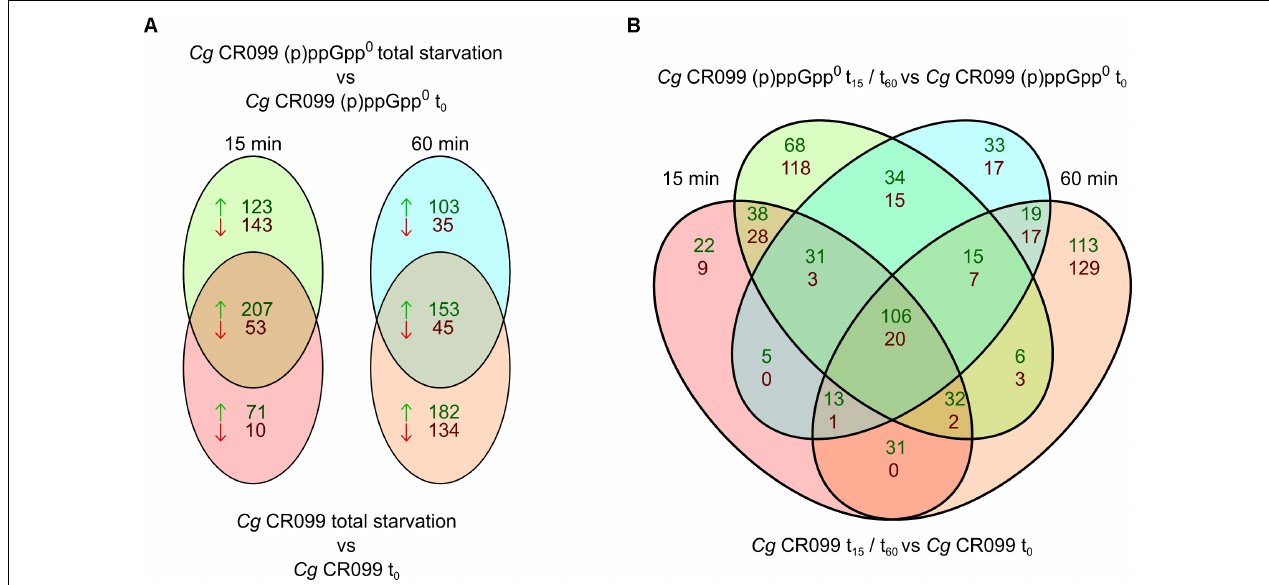
FIGURE 7 | Venn diagrams of differentially regulated genes between parental strain CR099 and (p)ppGpp 0 mutant CR099 (cid:49) rel (cid:49) relS (cid:49) relH for two stress exposure durations. For both strains, the stress-induced change in transcript levels was determined in relation to the unstressed initial state. (A) Venn diagrams of individual stress exposure durations. (B) Combined Venn diagram of both strains and stress exposure durations. Individual Venn diagram elements represent the genes differentially up- or downregulated in the respective time points (t15: left; t60: right) and strain backgrounds (CR099: bottom; CR099 (cid:49) rel (cid:49) relS (cid:49) relH : top). The numbers of positively regulated genes are shown in green and the downregulated genes in red. Differentially regulated genes of all subgroups are listed comprehensively with their corresponding log 2 ratios ( M -values) in Supplementary Tables S3–S13